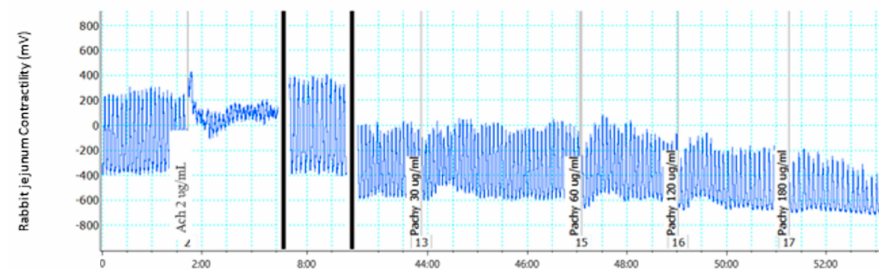
Figure 3. Effect of compound 6 on isolated rabbit jejunum.